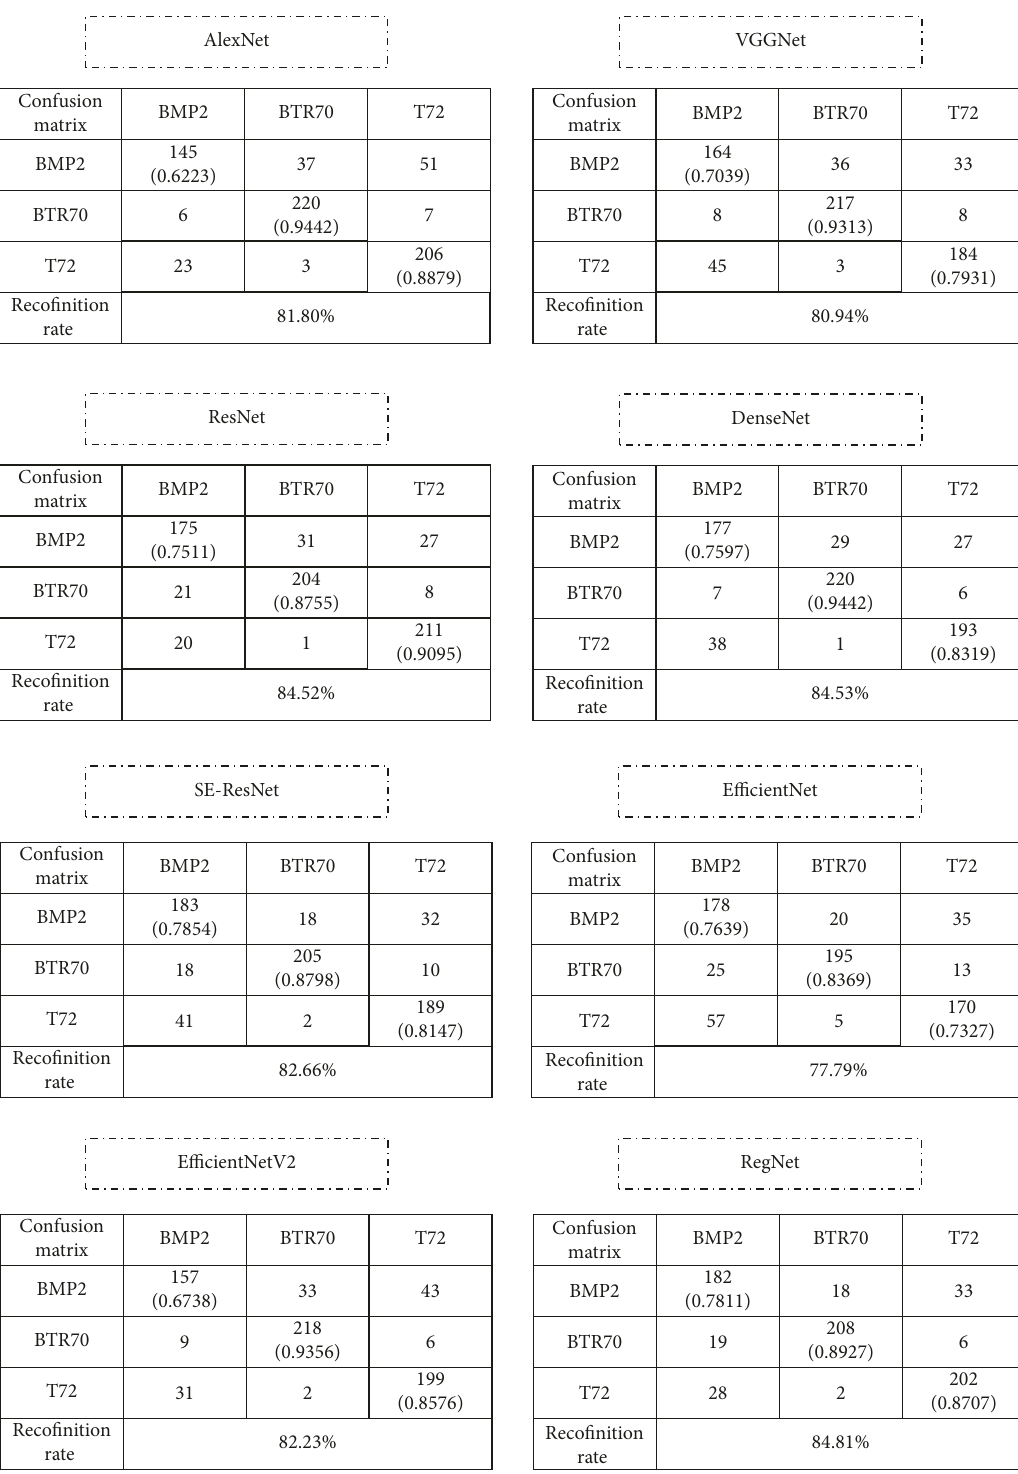
Figure 13: Confusion matrices for different CNN